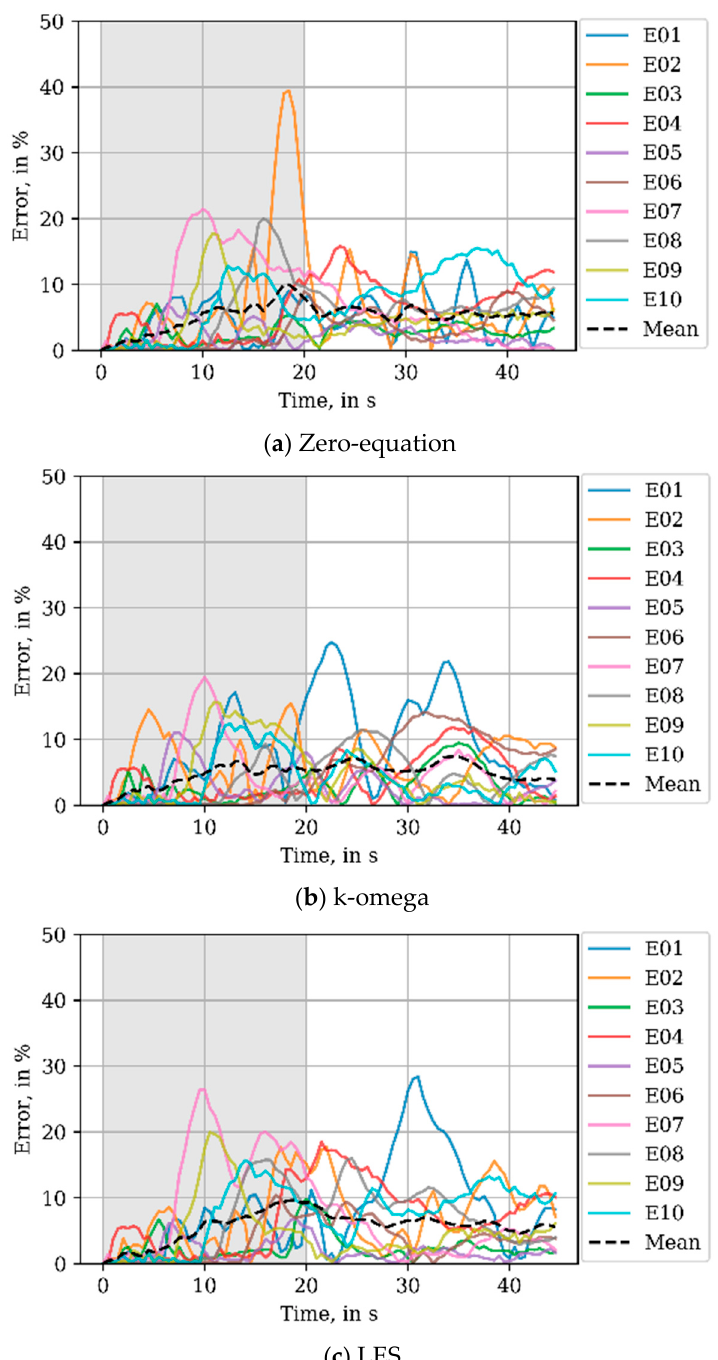
Figure 11. Time series of relative errors E i for ( a ) zero-equation, ( b ) k-omega, and ( c ) LES models.